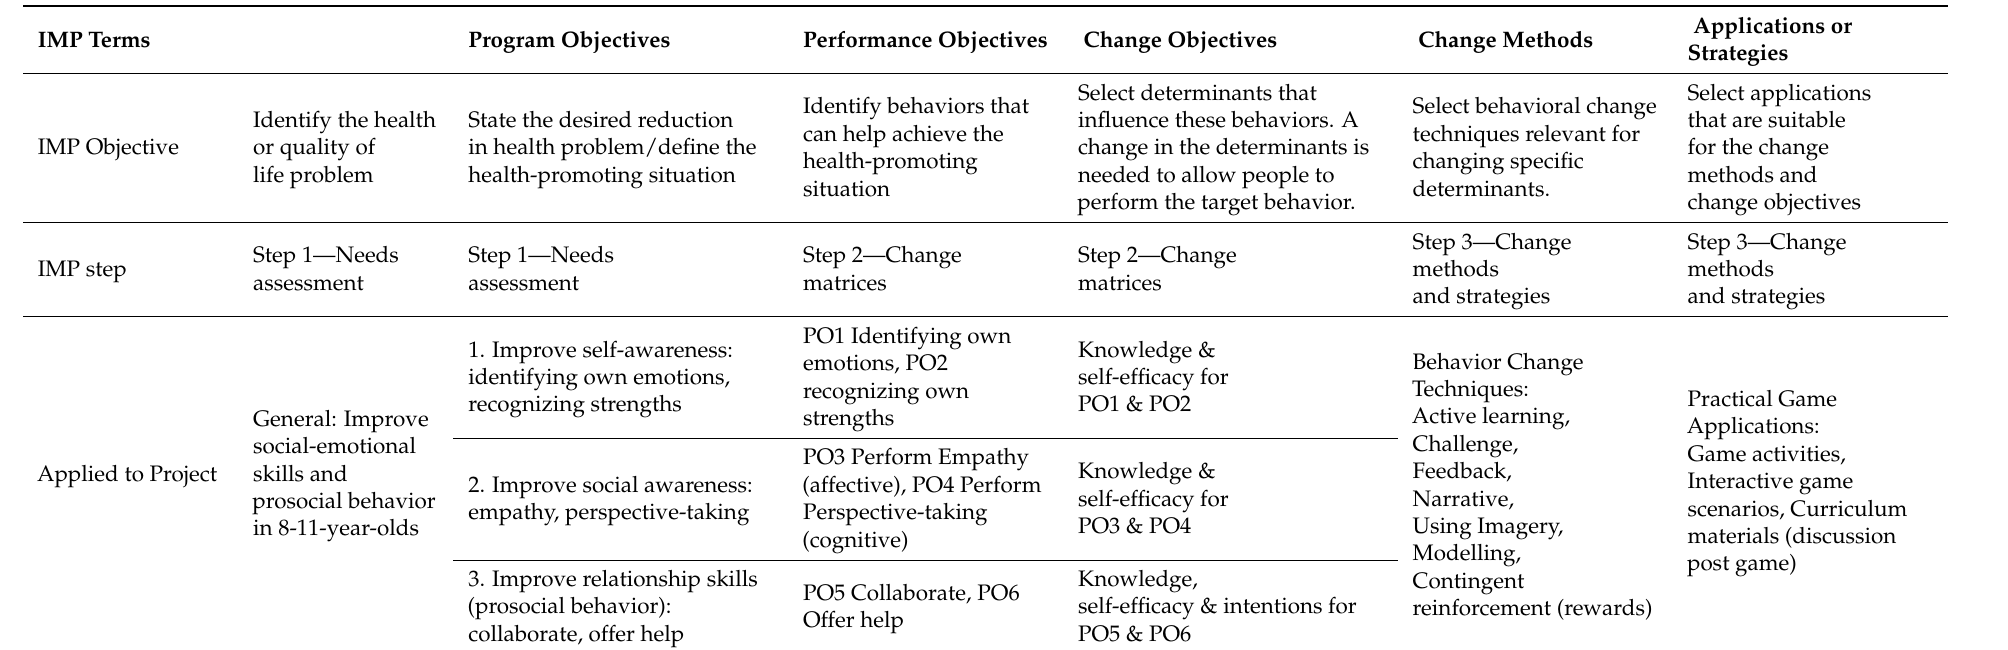
Table 1. Intervention Mapping Protocol Steps and